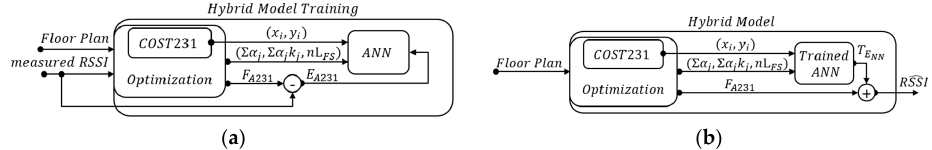
Figure 5. Flowchart of the hybrid model, ( a ) depicting the model input/output during the training; ( b ) demonstrating the input/output after the artificial neural network (ANN) is trained.